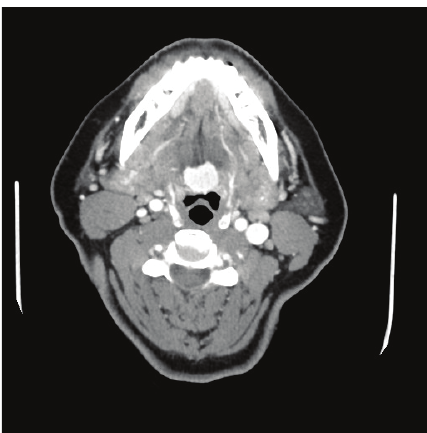
Figure 1: Axial CT neck showing a lingual thyroid. Figure 2: Sagittal CT neck revealing a lingual thyroid without a thyroid in its native